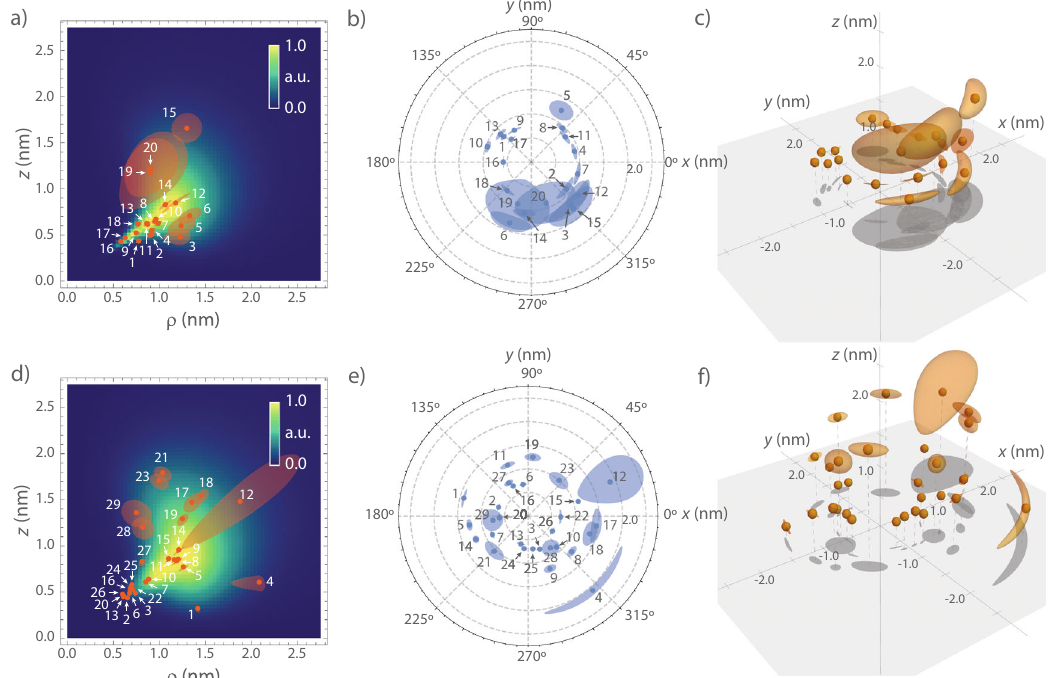
Fig. 5 Visualizations of the three-dimensional nuclear spin mapping. a Fitted spatial locations of the 13 C spins of NV1 (dots) shown in a ρ z -plot. The central NV spin is located at the origin. Note that our method is ambiguous with respect to an inversion at the origin. Therefore, all nuclei are plotted in the upper hemisphere. Color coding re fl ects the combined sensitive slice [Eq. (6)] taking all t β values as well as fi nite t ℓ and T (cid:6) showing the azimuth ϕ on the xy -plane. c Three-dimensional view of the nuclear positions. d – f Corresponding plots for the carbon spins of NV2. Uncertainties (±1 standard error) are shown as shaded areas or volumes, respectively, and are omitted if smaller than the data points. Index labels refer to Tables S3 and S4 in the Supplementary